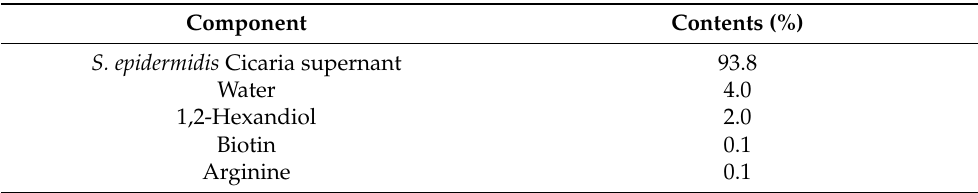
Table 4. Components of